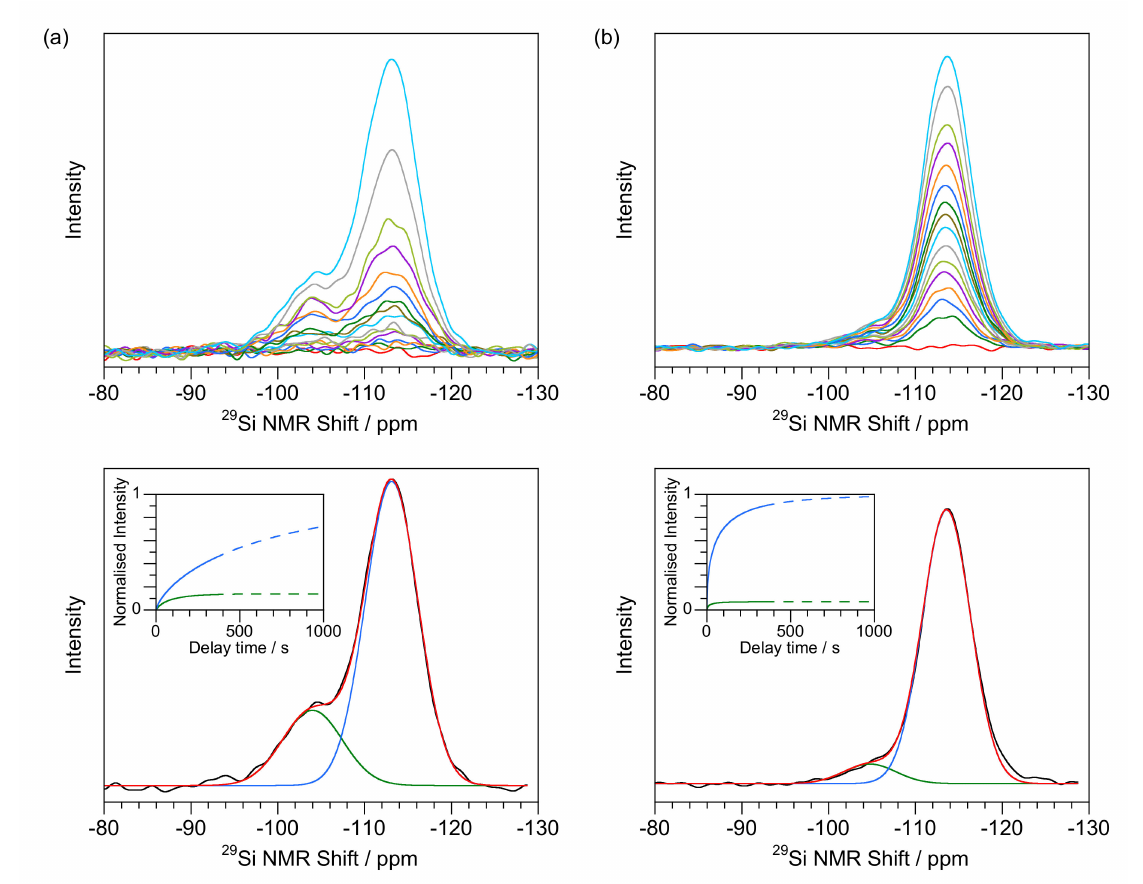
Figure 3. Evolution of signal with delay time for opal-CT ( a ) with a separated Q 3 peak (G32925 from Zelinograd, Qazaqstan) ( b ) less delineated Q 3 peak (GNEW24 from Kutahuya, Turkey). Top: spectra after delay times of 1, 2, 3, 5, 7, 10, 15, 20, 25, 35, 50, 75, 100, 200 and 400 s (with the zero-time measurement shown in red). Lower: Q 3 (green) and Q 4 (blue) fitting for the 400 s delay time data with infinite time extrapolated data shown in